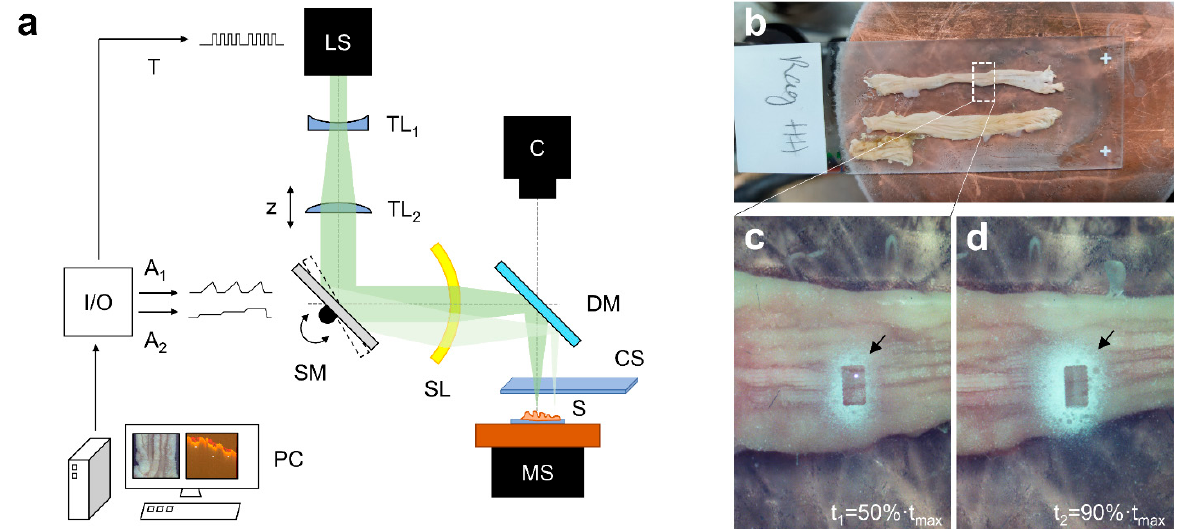
Figure 4. ( a ) Experimental ablation setup utilizing a nanosecond infrared laser system (LS) with a 2-axis scanning mirror (SM) in combination with a scanning lens (SL). A camera with objective (C) is monitoring the ablation of the sample (S) through a dichroitic mirror (DM). The sample is cooled down to about − 10 °C and can be displaced by a manual stage (MS). The aerosol is collected by a glass slide (CS), which is placed directly above the sample. PC, control computer; I/O, input/output card; A 1/2 , analog line 1/2; T, trigger line; TL 1/2 , telescope lens 1/2. ( b ) Murine colon that is transversally cut open and placed on an objective slide for better handling. In the region of interest, the colon is sampled layer-by-layer with NIRL. ( c , d ) Pictures of the ablation area at two time points (t 1 and t 2 ) of the ablation time (t max ). The trapped and dried aerosol (black arrow) appears white on the glass slide. A rectangular area within the dried aerosol is lost due to the scanning process.